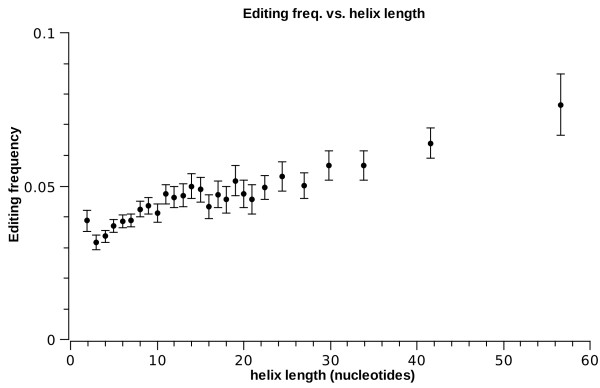
E1 frequency vs. helix length.